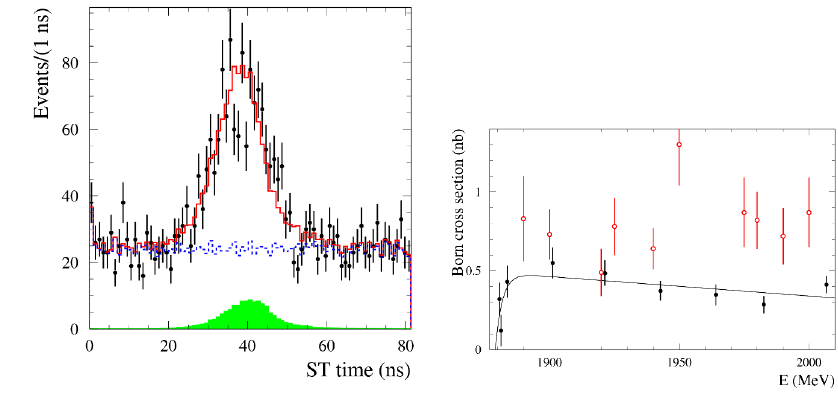
Figure 2. Left: the distribution of the calorimeter time signal relative to the beam crossing signal in √ s = 1900 − 2005 MeV (points with error bars). the collider for e + e − → n ¯ n candidate events with The histogram is a sum of the distributions for signal e + e − → n ¯ n and background events. The dashed histogram is the cosmic ray background. The shaded histogram is the e + e − annihilation background. Right: the cross section of the process e + e − → n ¯ n measured by SND. The filled circles represent the preliminary results based on the 2017 data set, while the open circles show the previuos measurements based on 2011–2012